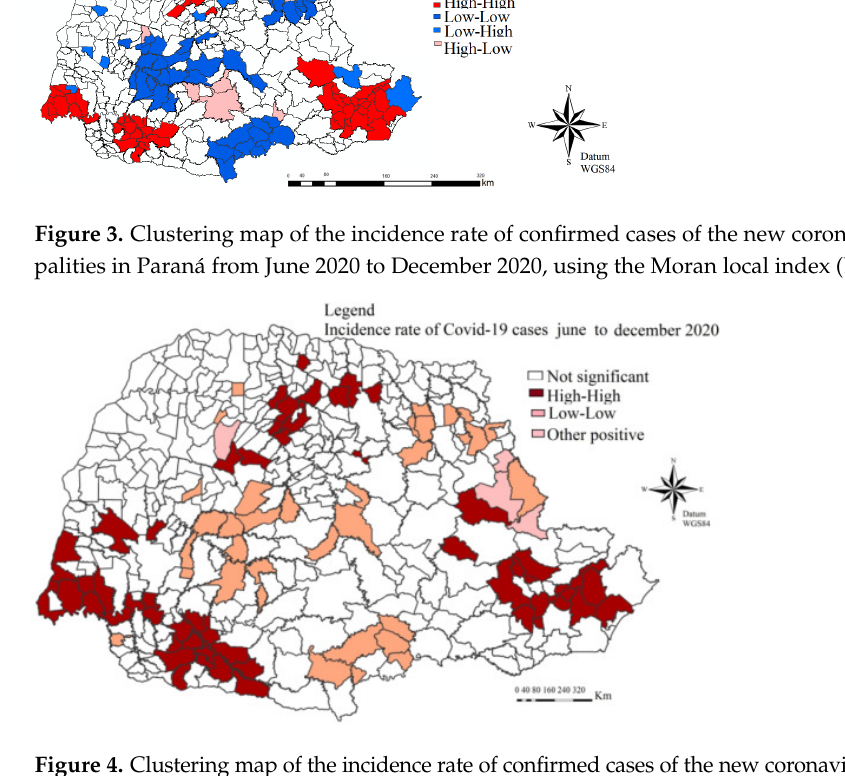
Figure 4. Clustering map of the incidence rate of confirmed cases of the new coronavirus by municipali- ties in Paraná from June 2020 to December 2020, through the analysis of the local Geary index ( c i )